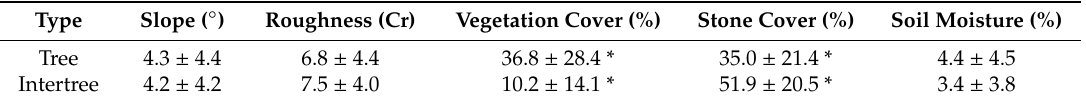
Table 2. Environmental plot characteristics of tree and intertree areas (* significant di ff erence between tree and intertree area with p -value < 0.05).